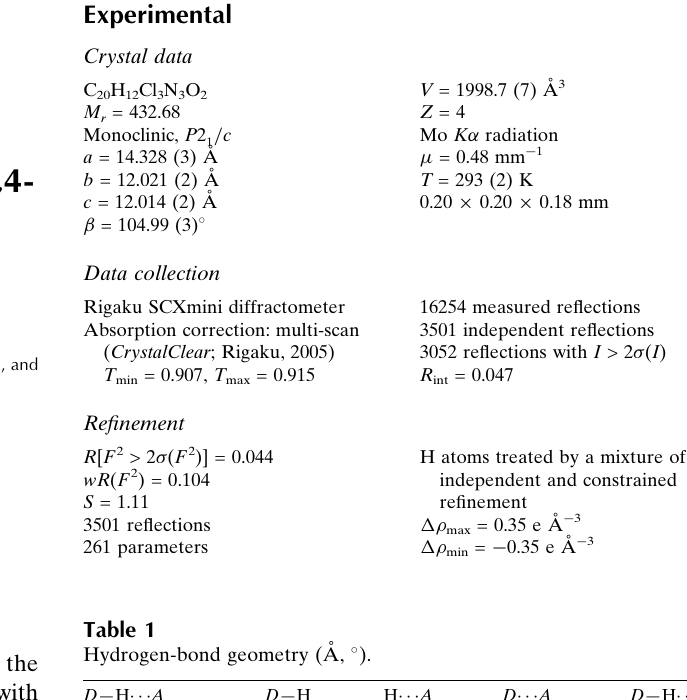
Hydrogen-bond geometry (A˚ , (cid:1) ). D —H (cid:2)(cid:2)(cid:2) A